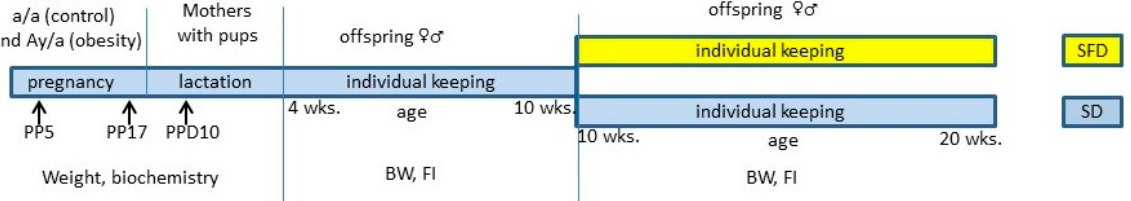
Figure 7. Experimental design. The top line shows the mice under study, and the bottom line shows the measured parameters. Blue color indicates the period of consumption of the standard diet; yellow color—the period of consumption of the sweet and fatty diet. There were 6 experimental groups of mothers ( A y /a and a/a mothers at PP5, PP17, and PPD10) with 7 females in each group, and 8 experimental groups of the offspring: 6 male and 8 female offspring of A y /a mothers and 7 male and 7 female offspring of a/a mothers that consumed SFD; 5 male and 8 female offspring of A y /a mothers and 7 male and 8 female offspring of a/a mothers that consumed SD. FI – food in- take.